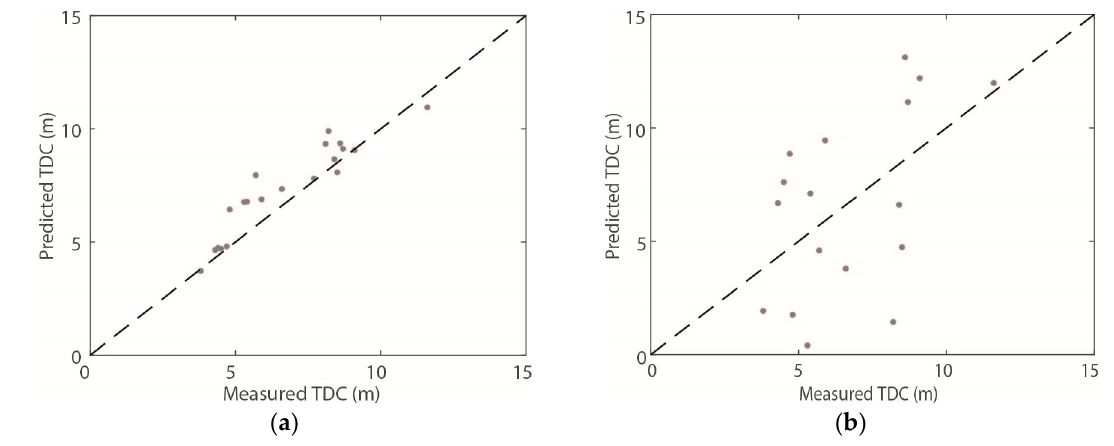
Figure 13. Cross plots of measured TDC thickness vs. predicted TDC thickness with a DBN model ( a ), and measured TDC thickness vs. predicted TDC thickness with instantaneous amplitude ( b ).